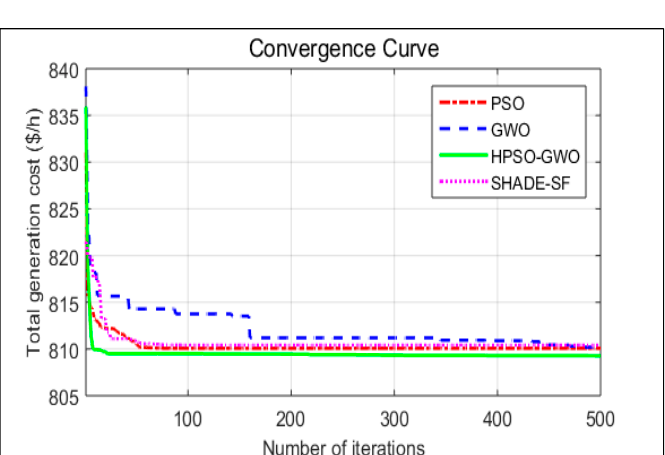
Figure 25. OPF convergence curves comparison (Case 5).